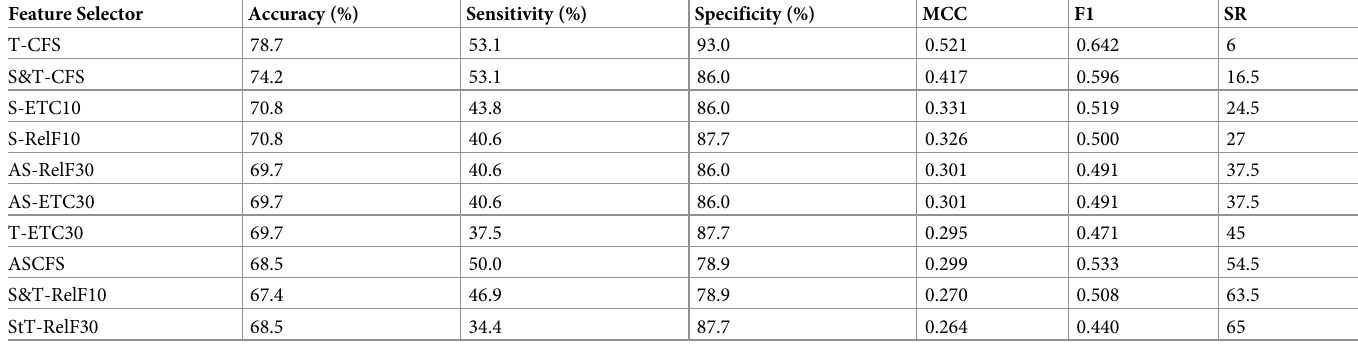
Table 3. Unoptimized ranked metrics for top 10 subsets with a random forest classifier. Numbers after feature selector ETC and RelF indicate the number of features from that subset. Feature